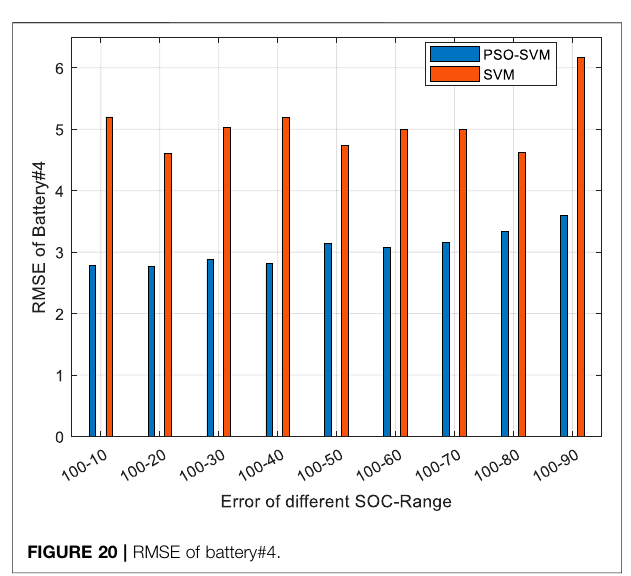
FIGURE 20 | RMSE of battery#4.